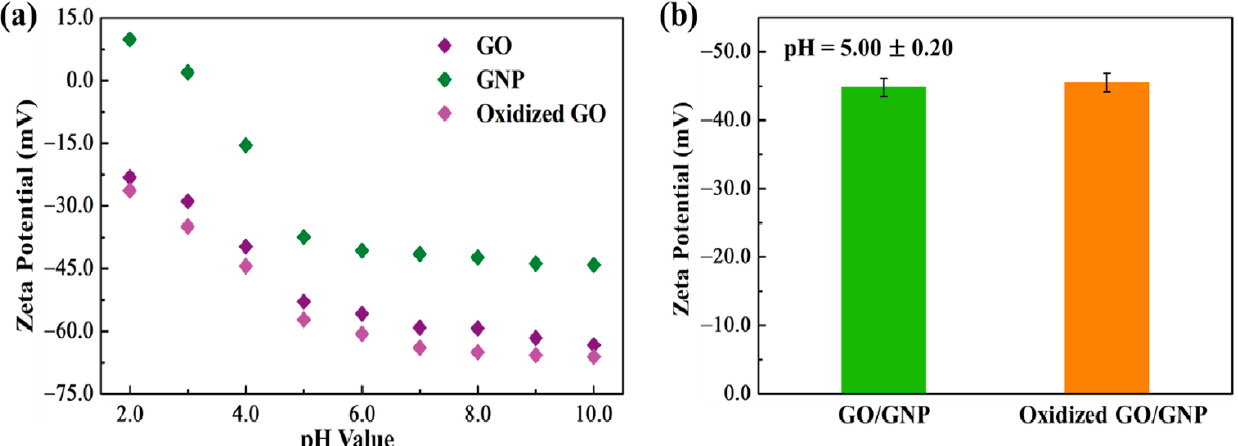
Figure 1. ( a ) Zeta potential results of graphene oxide (GO), graphene nano-platelet (GNP), and KMnO 4 oxidized GO. ( b ) The mixture of GO/GNP and oxidized GO/GNP solutions.